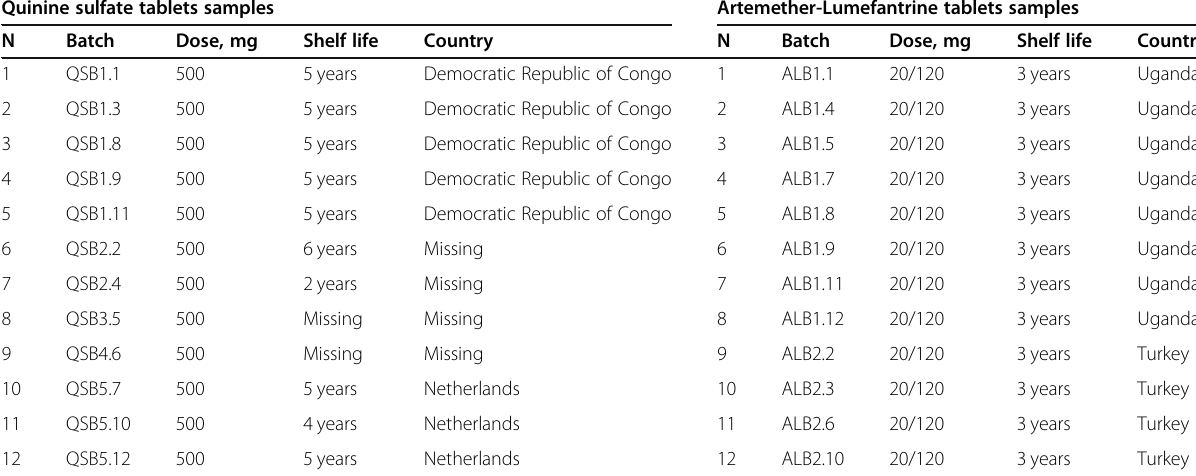
Table 1 Samples of quinine sulfate and Artemether-Lumefantrine brands tested Quinine sulfate tablets samples